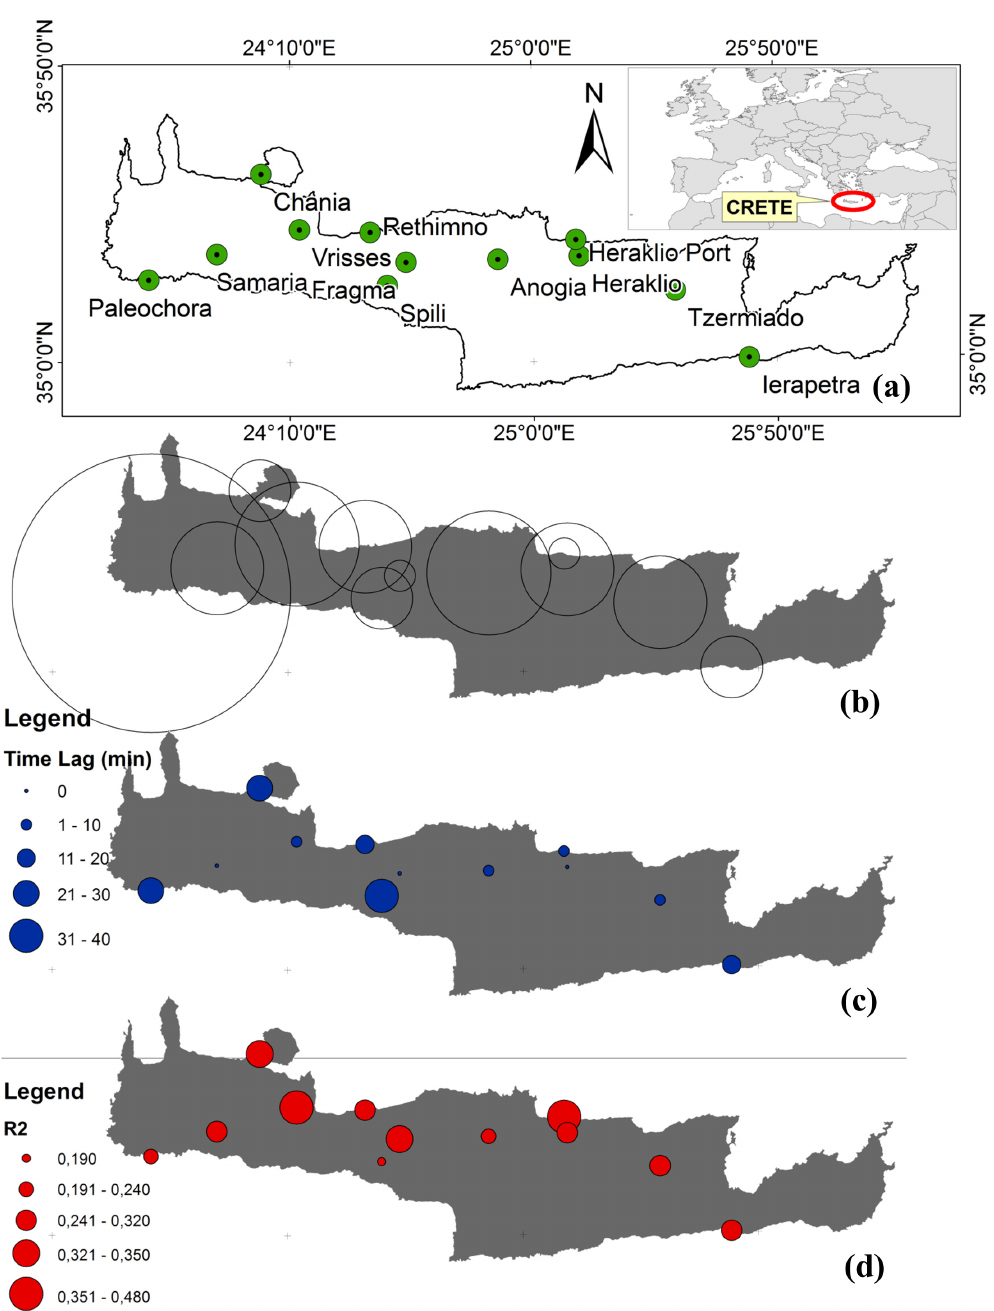
Fig. 1. (a) Location of Crete Island and meteorological stations of National Observatory of Athens (NOA), (b) optimum radius, (c) optimum time-lag and (d) attained r 2 , according to Table 2